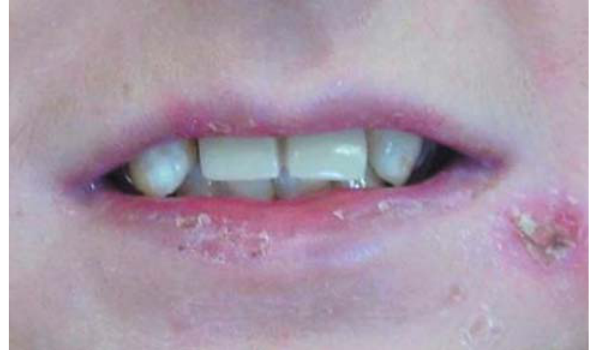
FIGURE 4- Frontal view of the patient’s face partially showing the prosthetic appliance with two upper